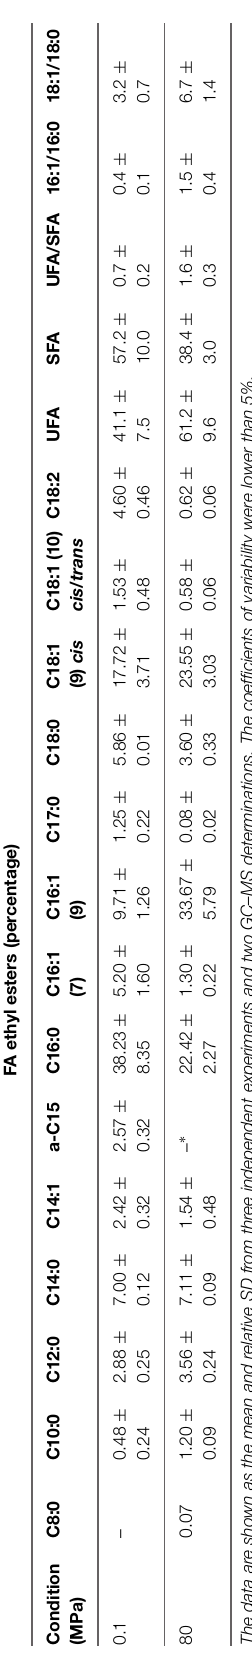
after the HPH treatment. The main FAs detected in both control and HPH-treated cells were C16:0, C18:1 (cid:2) 9 cis and C16:1( (cid:2) 9) cis . The HPH treatment strongly increased the percentage of total UFAs with a proportional reduction of the saturated fattty acid (SFA) percentage; moreover, the UFA/SFA ratio